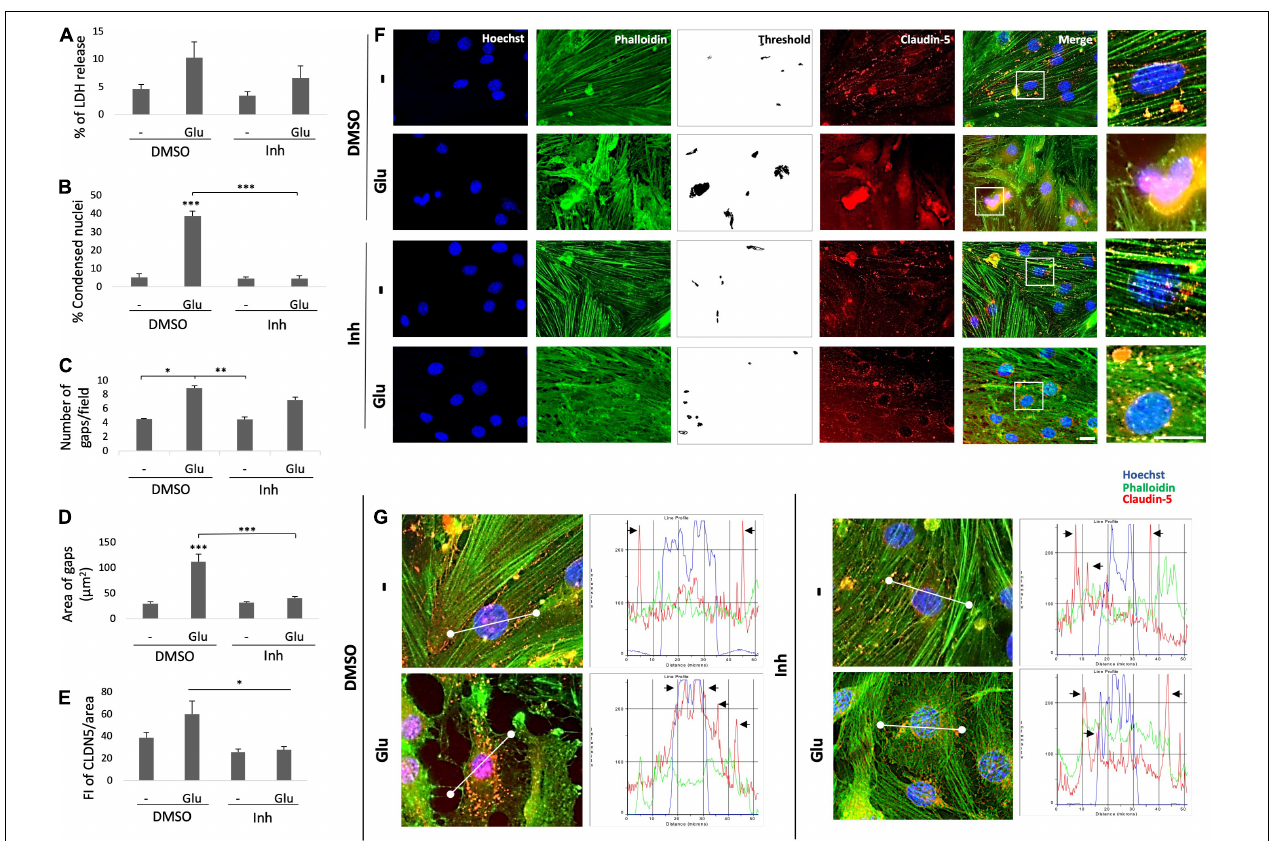
FIGURE 4 | BACE1 inhibition protects ECs from the damaging effects of glutamate. (A) Percentage of LDH release by ECs (bEnd.3) after 24 h of treatment. The data are presented as the mean ± SEM of n = 7. Kruskal-Wallis test. (B) Percentage of condensed nuclei for each treatment. These were quantified from 20 fields per treatment for each n ( n = 4). The data are presented as the means ± SEM. (C) Number of gaps per field from threshold image (gaps = spaces between cells indicating disruption of the monolayer) presented as the mean ± SEM of n = 4. Kruskal-Wallis test followed by Dunn’s test with the Bonferroni correction. (D) Area of gaps between cells expressed in µ m 2 ; the area was quantified as the mean of the black area in threshold images from 20 fields per treatment for each n ( n = 4). ANOVA followed by Tukey’s test. (E) FI of CLDN5 per unit area was quantified from 20 cells per treatment for each n ( n = 4 performed in duplicate) and divided by unit area. f) Morphological characterization of ECs showing the nuclei stained with Hoechst (blue), the F-actin cytoskeleton visualized with Alexa Fluor 488 phalloidin (green), and the tight junction protein CLDN5 visualized with Alexa Fluor 594 (red). Magnification: 60x. Scale bar: 20 µ m. The zoomed insets show the condition of the nuclei, the state of the actin cytoskeleton and the distribution of CLDN5. (G) Fluorescence profiles (right column) showing the cellular distribution of CLDN5 (red line) in relation to the nucleus (blue line) and cytoskeleton (green line) based on the representative images (left column). The black arrows indicate the tight junction peaks to show the changes in CLDN5 distribution by the treatment. The white line drawn on each cell represents a distance of 50 µ m. The data are presented as the means ± SEM, ANOVA followed by Tukey’s test. DMSO = vehicle, Inh = β -secretase inhibitor IV, - or Glu refers to glutamate treatment. All experiments were performed in duplicate. * P < 0.05, ** P < 0.01, *** P <